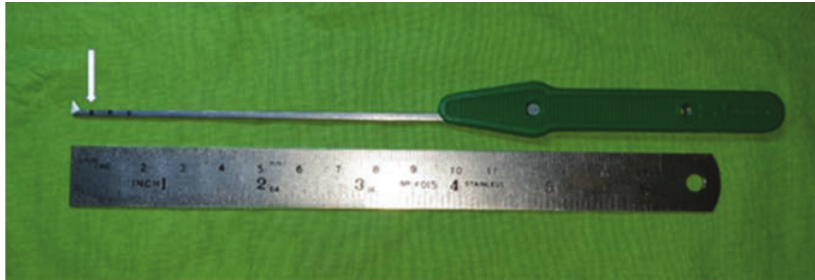
5mm, 10mm and 15mm (arrow) marked from the tip of hook blade. Fig. 5: